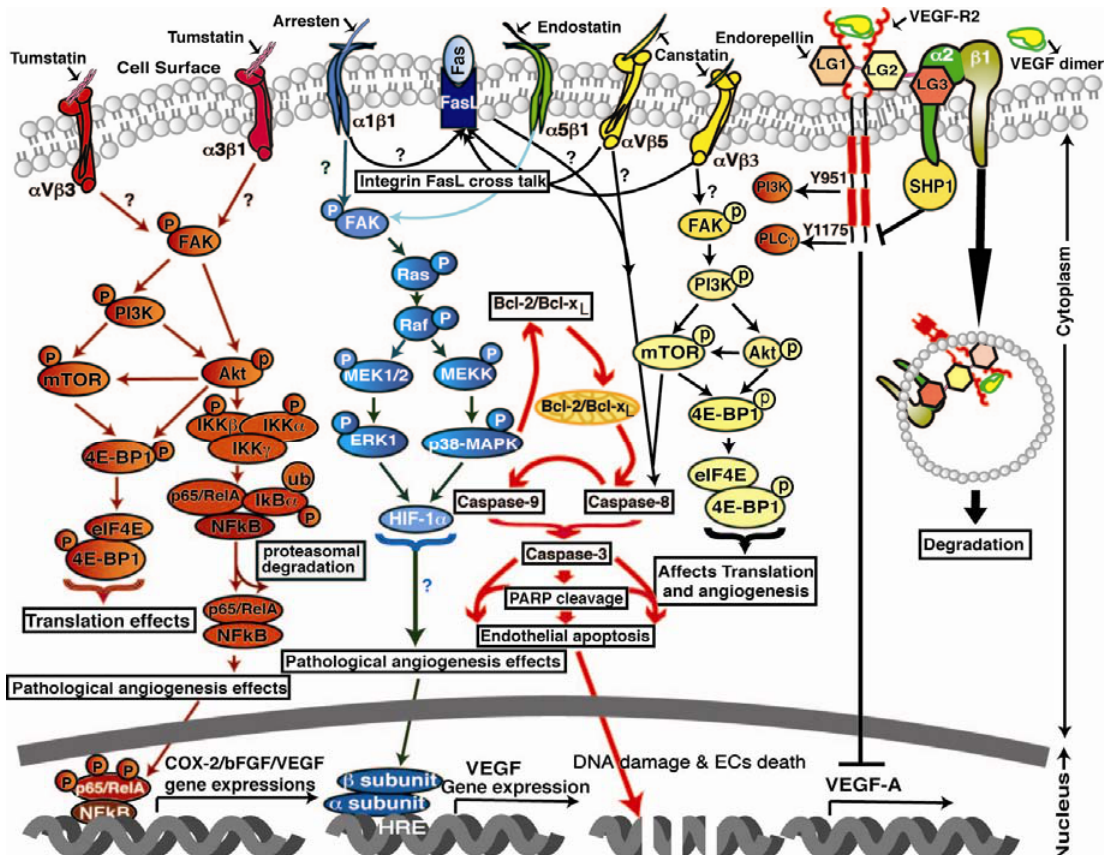
Figure 1. Illustration of extracellular matrix derived endogenous angioinhibitors.